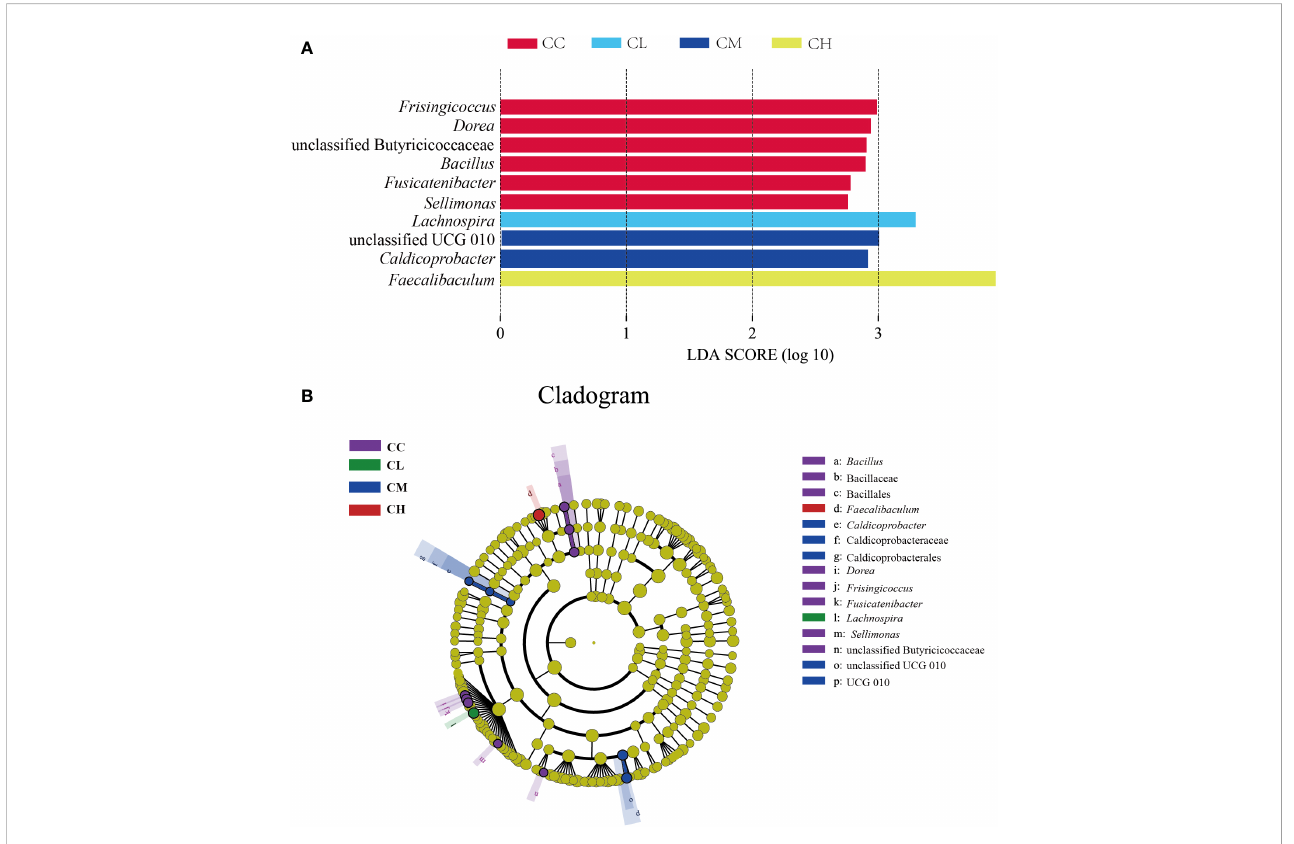
FIGURE 8 Characteristic bacteria of mice with GFPS intervention. (A) LDA score plots. (B) LEfSe